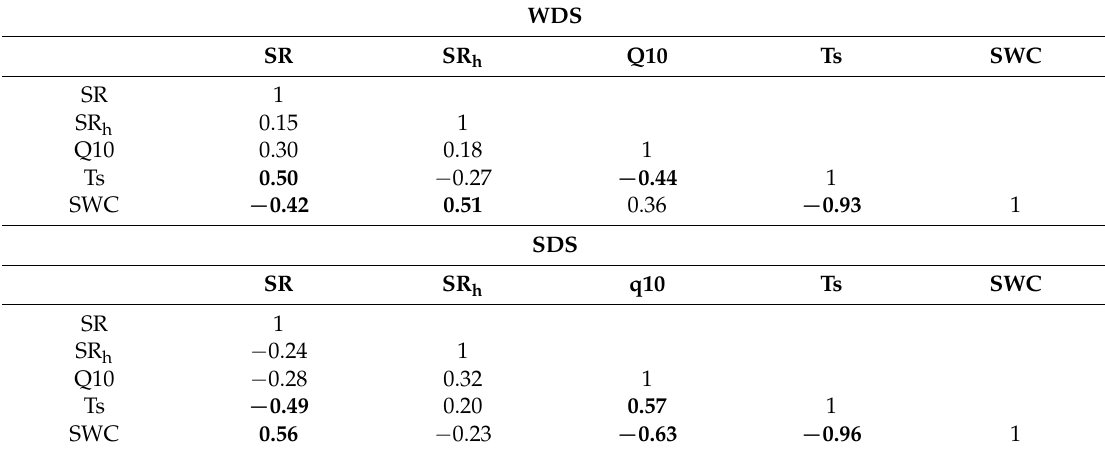
Table A5. Correlations table between the soil CO 2 emission, heterotrophic soil CO 2 emission, Q 10 and soil microclimatic variables in the two sites. Bold values are significant at p <